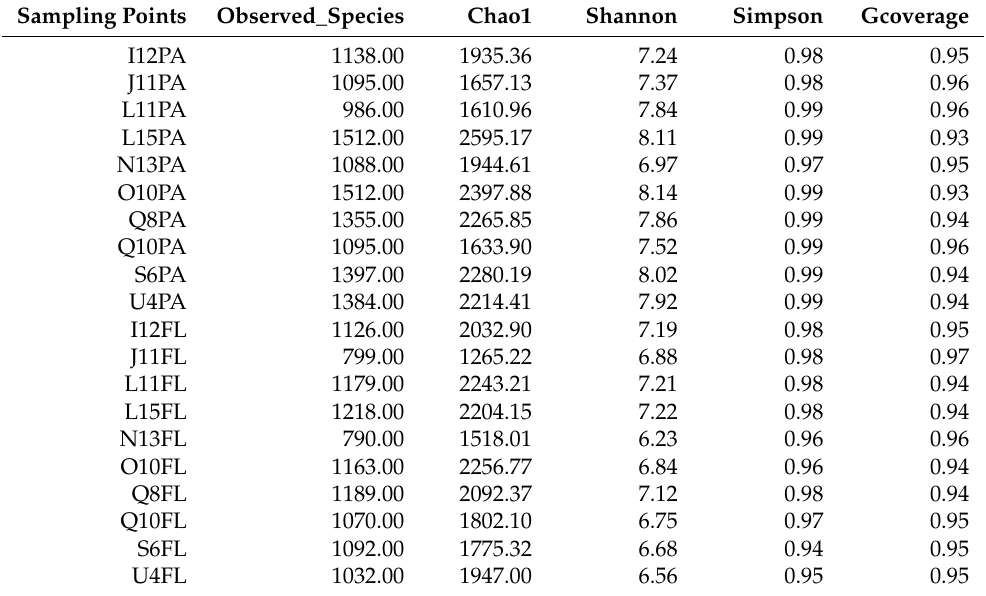
Table A3. Alpha diversity indices of PA and FL bacterial communities at 10 sampling sites in the surface water of Wuliangsuhai